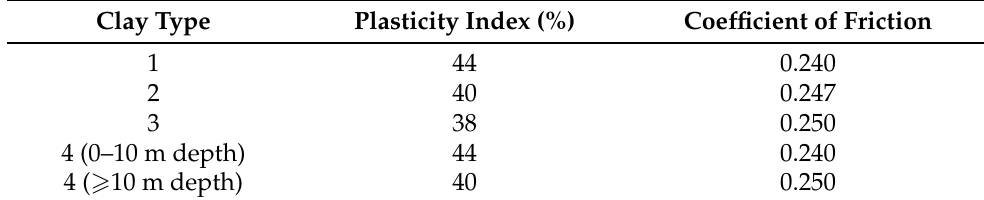
Figure 5. The relationship between the plasticity index and the coefficient of friction (after [21]). Table 4. Coefficient of friction for each type of